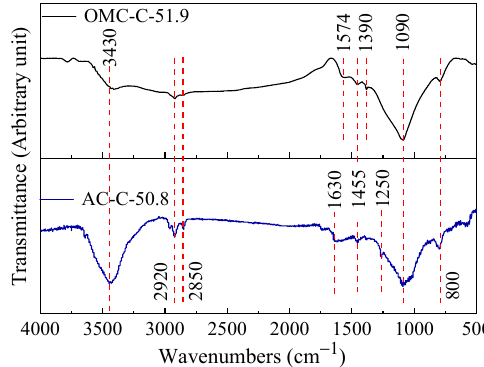
Figure 3. FTIR spectra of the hierarchical carbons.